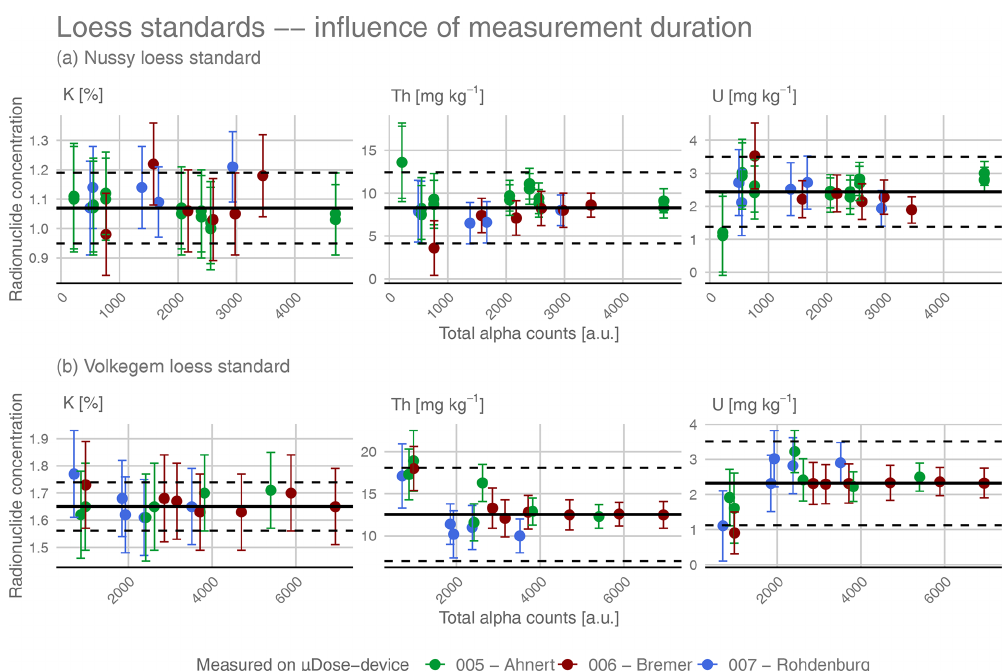
Figure 5. Results from µ Dose measurements of two loess standards (Nussy – a ; Volkegem – b ). Values on the x axis represent the number of total α counts. The y -axis values give the respective radionuclide concentration either in percent (K) or in milligrams per kilogram (mgkg − 1 ) (Th and U). The different colours of the symbols represent three different µ Dose devices (see legend). The bold lines illustrate the median values derived from the determined results. Dashed lines indicate the 2 σ